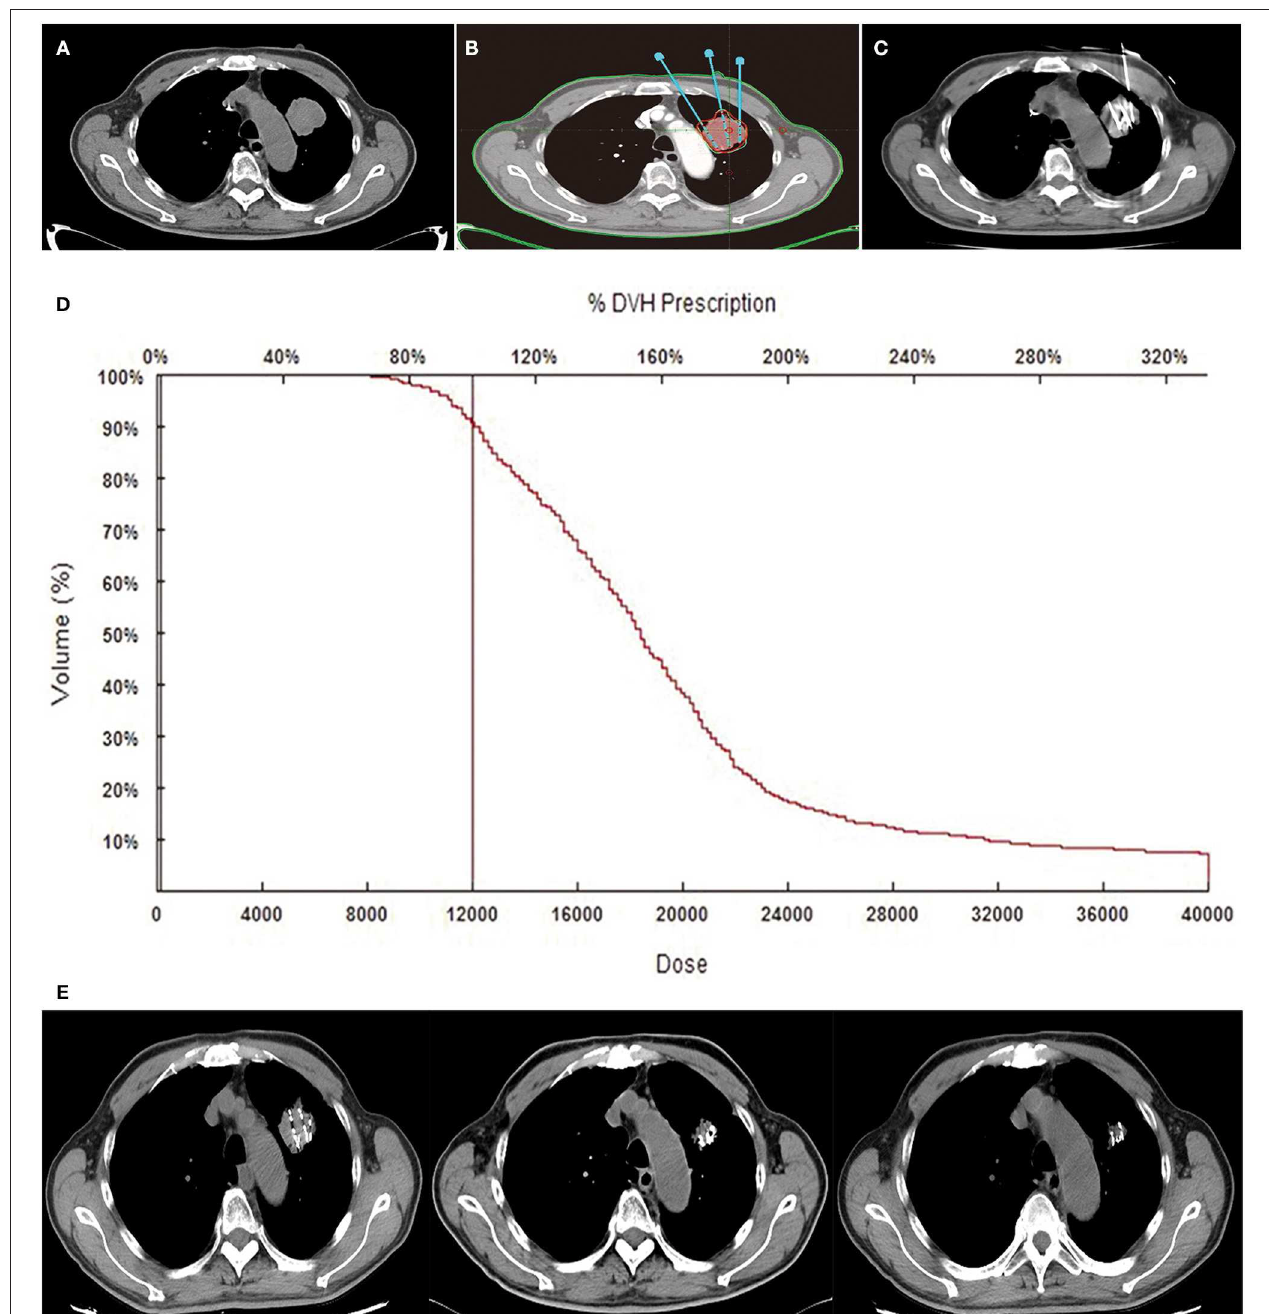
FIGURE 1 | Tumor, treatments, and follow-up CT. An 81-year-old male patient with NSCLC received RIS implantation. Preoperative CT images showed the oligometastatic lesion was located in the upper lobe of the left lung (A) . Isodose curves and planning target volume plotted by TPS. The red line shows the planning target volume, and the green line shows the 120-Gy isodose curves (B) . A total of 30 125 I seeds were implanted into the tumor under CT guidance, and the radioactivity of the seed was 0.6 mCi (C) . Dose–volume histograms (DVH). The prescription dose is 120Gy during planning. A total of 90% of the tumor target received 120.0Gy, and 95.4% of the tumor received 100% of the prescribed dose (D) . Gradually, the mass shrunk at the second, fourth, and sixth months on the following CT images (E) .